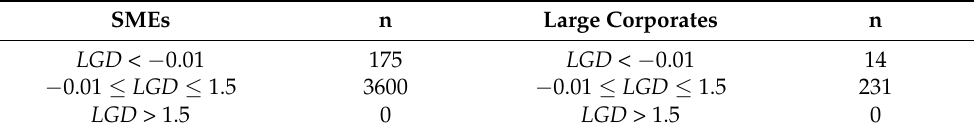
Table 2. LGD values with the associated number of observations for SMEs and large corporates. SMEs n Large Corporates n LGD < − 0.01 175 LGD < −